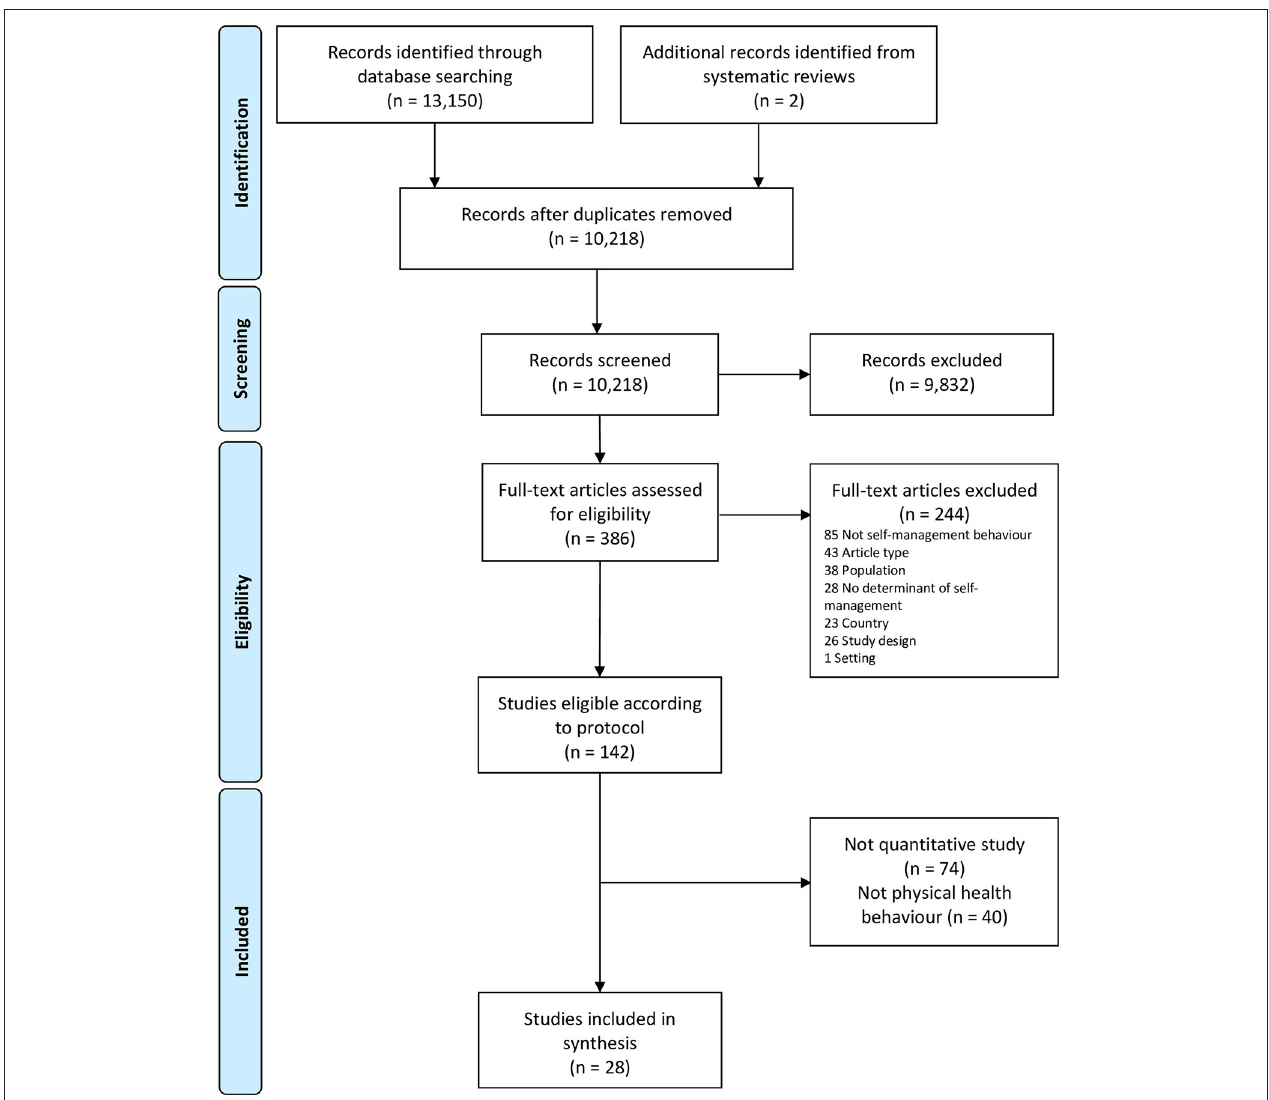
FIGURE 1 | PRISMA